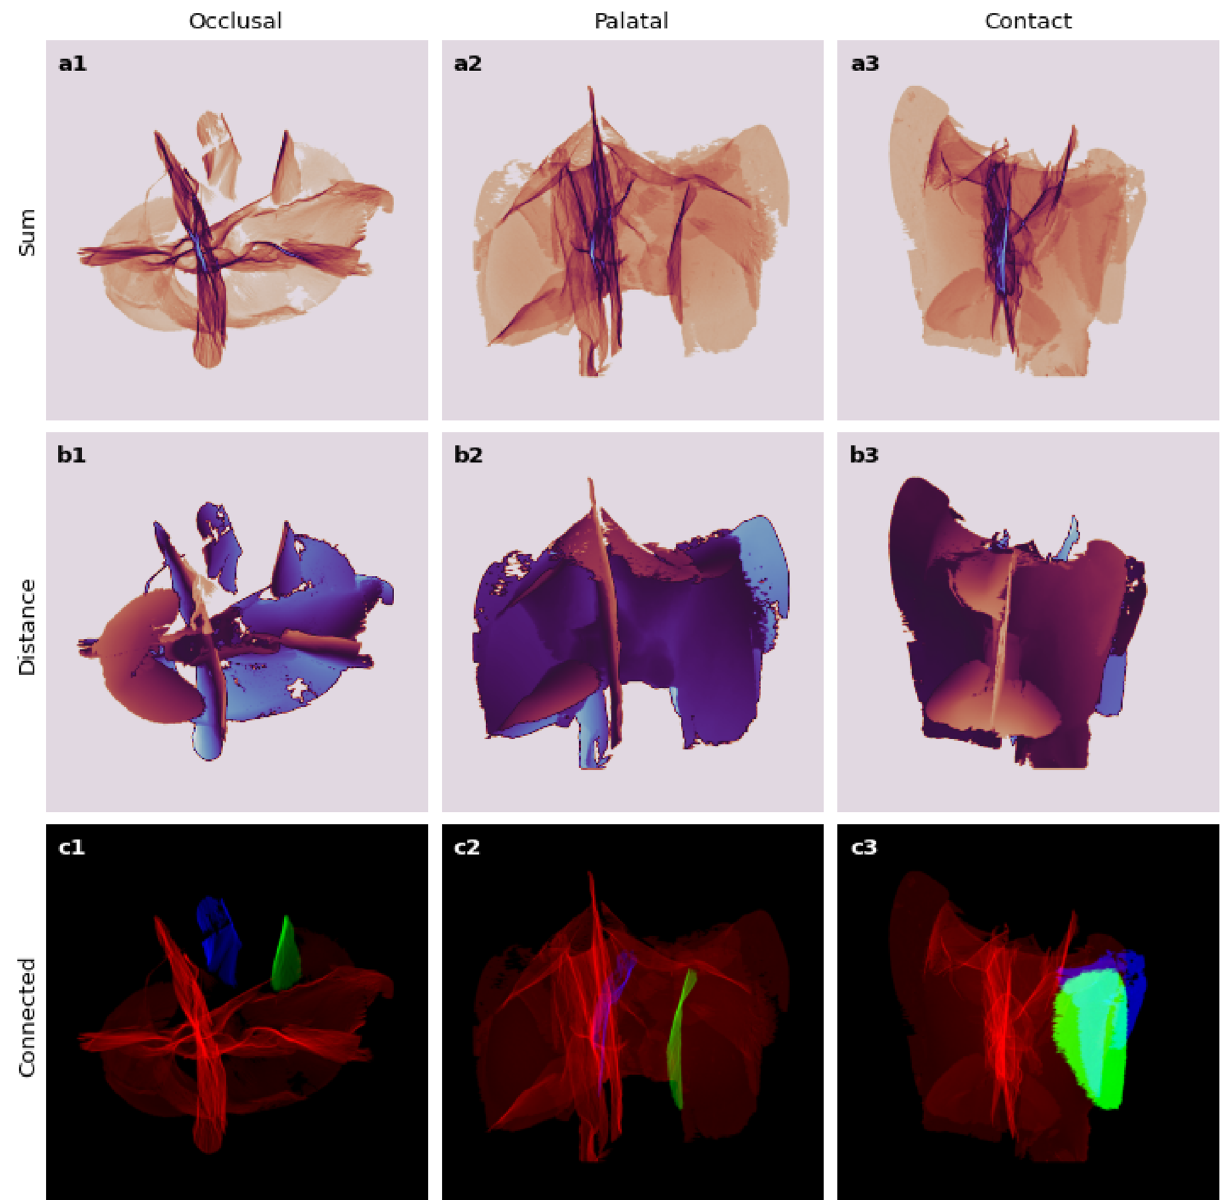
Figure 7. An intricate star-shaped network of cracks after removing small isolated groups. ( a1 – a3 ) Projected density maps (bluish represents higher / brownish lower). ( b1 – b3 ) Distance to the nearest crack voxel along the line of sight (bluish further / brownish closer). ( c1 – c3 ) Three largest connected crack groups isolated and colour-coded (red—largest, green—2nd largest, blue—3rd). “NumPy 1.24.0” 49 (https:// numpy. org) was used to process data-cubes, which were visualized with “Matplotlib 3.6.0” 50 (https:// matpl otlib.